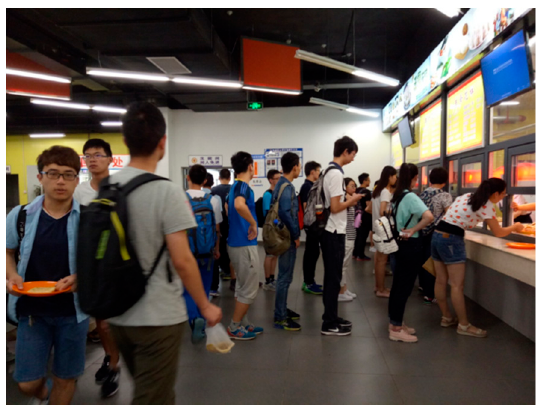
Figure 9. Students lined up in the no. 3 student cafeteria of Tianjin University.